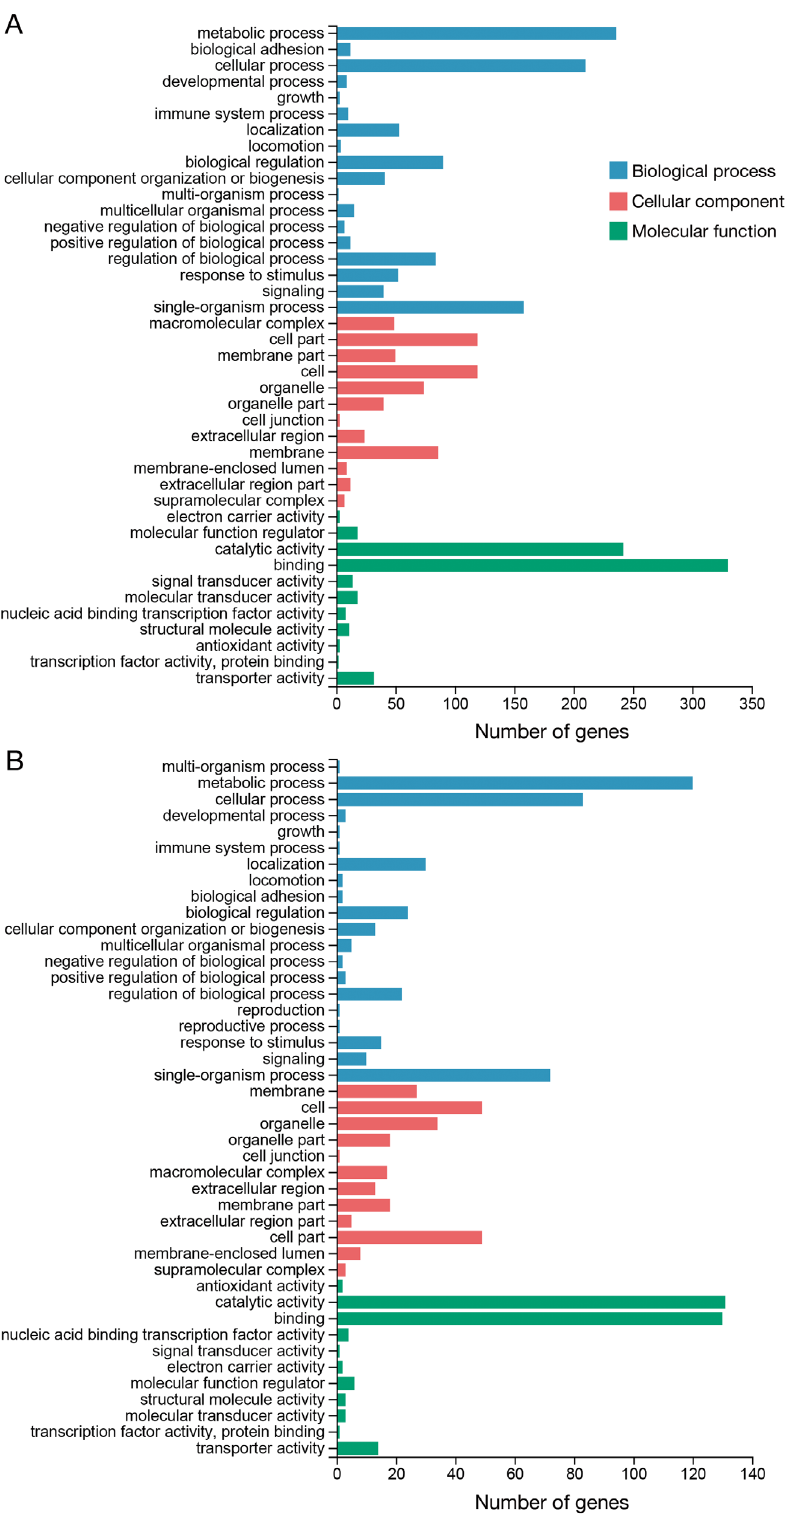
Fig. 4. Gene ontology (GO) terms based on the differentially expressed genes (DEGs) of the yellow drum (A) 8unfed-vs.-16fed and (B) 16unfed-vs.-16fed groups. Horizontal axis shows the number of DEGs enriched in each GO